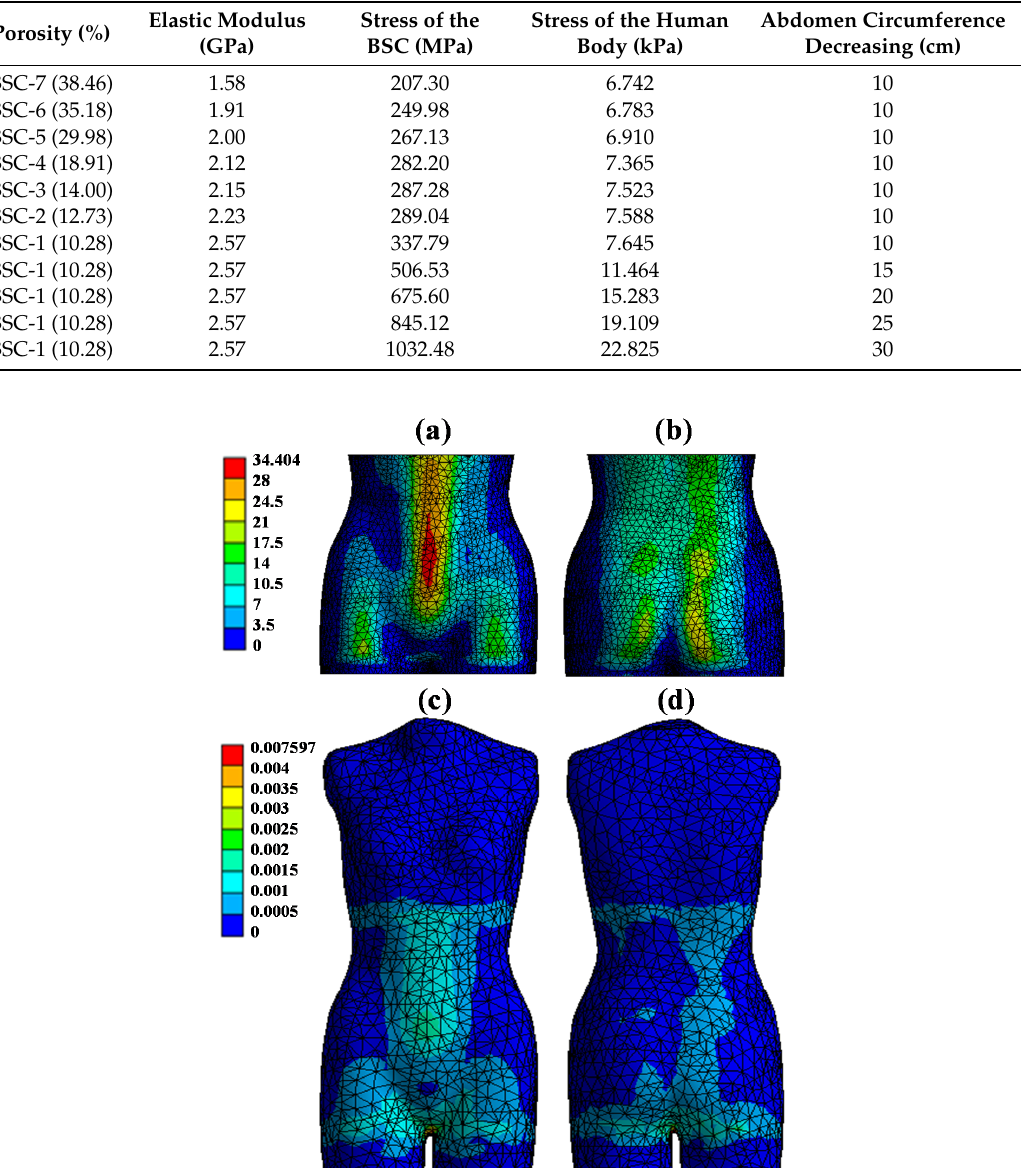
Table 3. Experiment results between the porosity, the elastic modulus of the knitted BSCs, the abdomen circumference decreasing, and the stress of the BSC and human body.